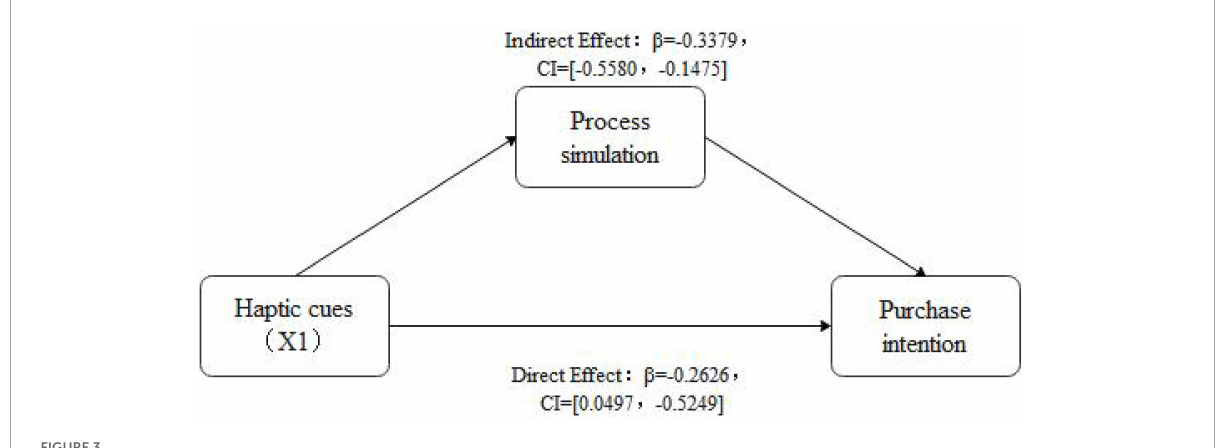
FIGURE3 The mediating effect of process